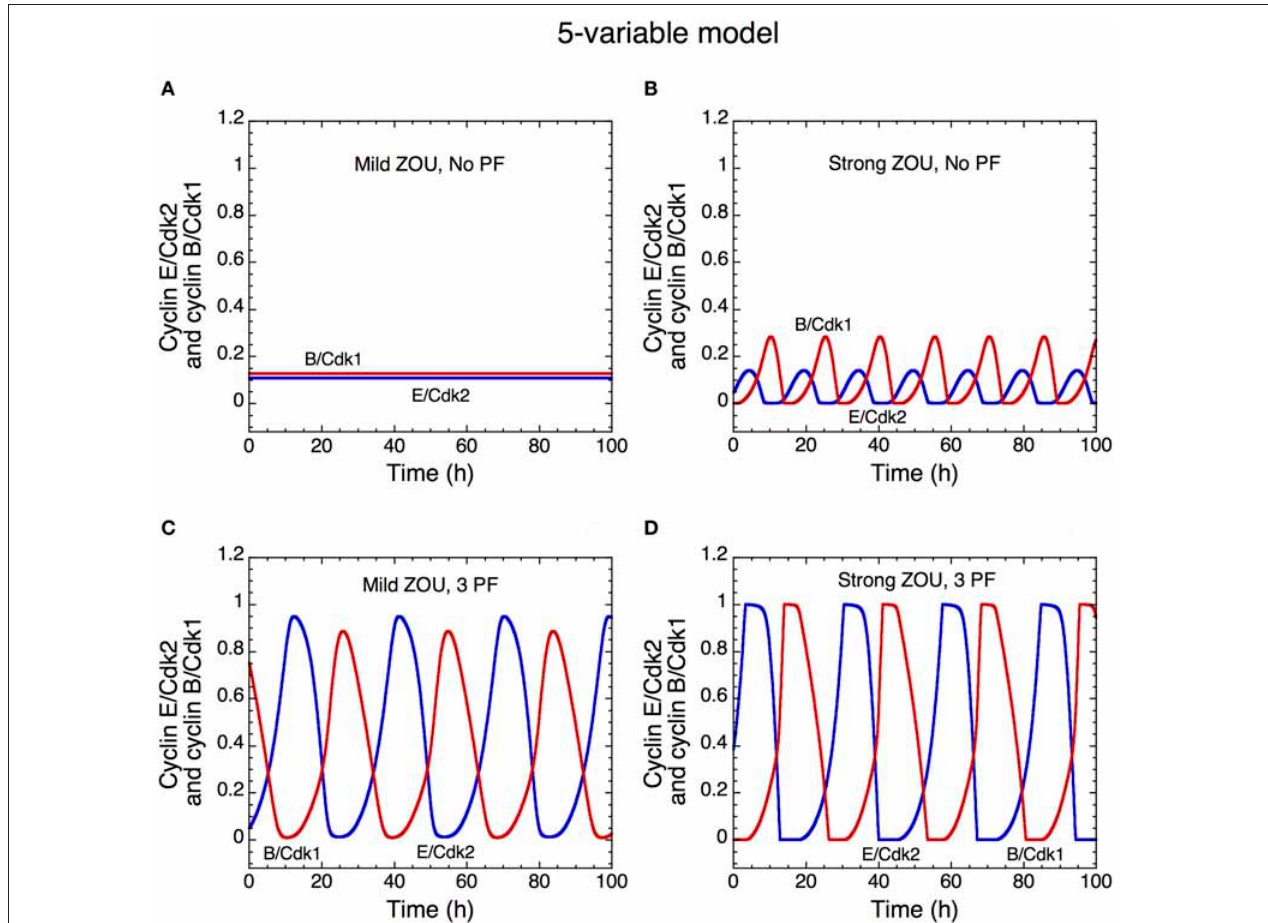
FIGURE 13 | Oscillatory dynamics of the skeleton model for the Cdk network driving the mammalian cell cycle: role of zero-order ultrasensitivity (ZOU) and positive feedback. The curves show the time evolution of cyclin E/Cdk2 (in blue) and cyclin B/Cdk1 (in red) in the presence of mild ultrasensitivity ( K = 0 . 1 μ M in A and C ) or strong ultrasensitivity ( K = 0 . 005 μ M in B and D ), and in the absence of any PF loop ( b 1 = 0, b 2 = 0, K ib = 1000 μ M in A , B ) or presence ( b